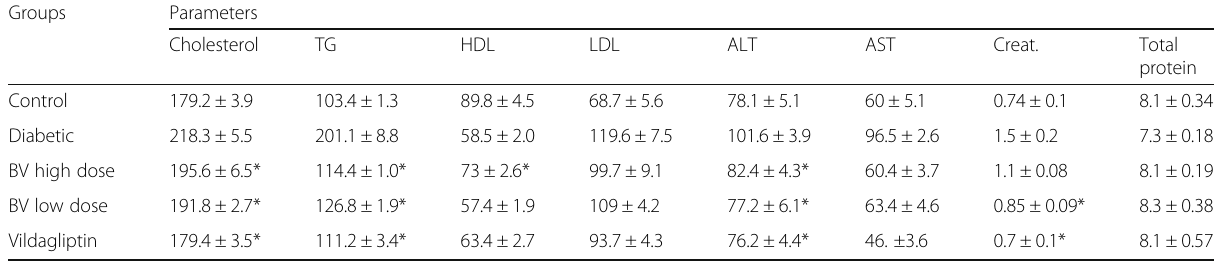
Table 1 Effect of treatment with BV and vildagliptin on biochemical parameters after 6 weeks in diabetic rats Groups